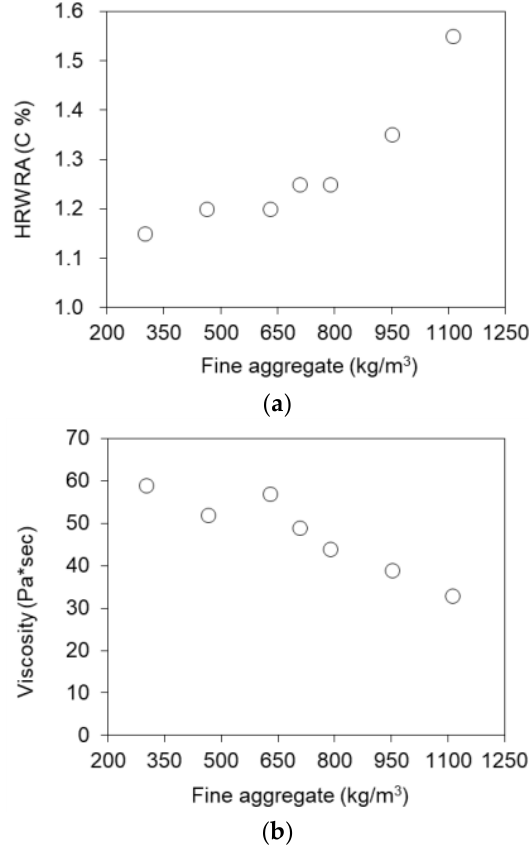
Figure 20. Effect of fine-aggregate volume. ( a ) HRWRA. ( b ) Viscosity.